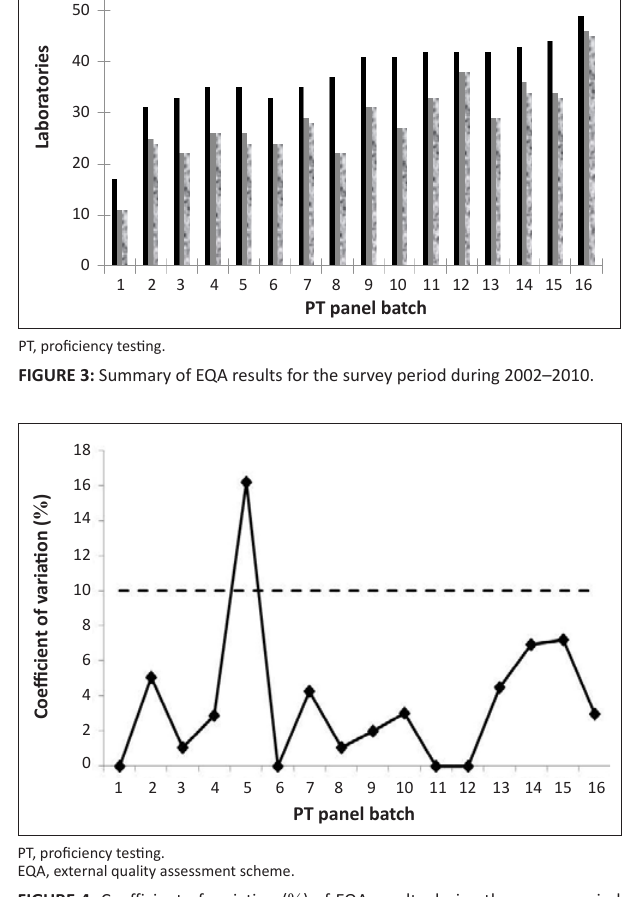
FIGURE 4: Coefficient of variation ( % ) of EQA results during the survey period